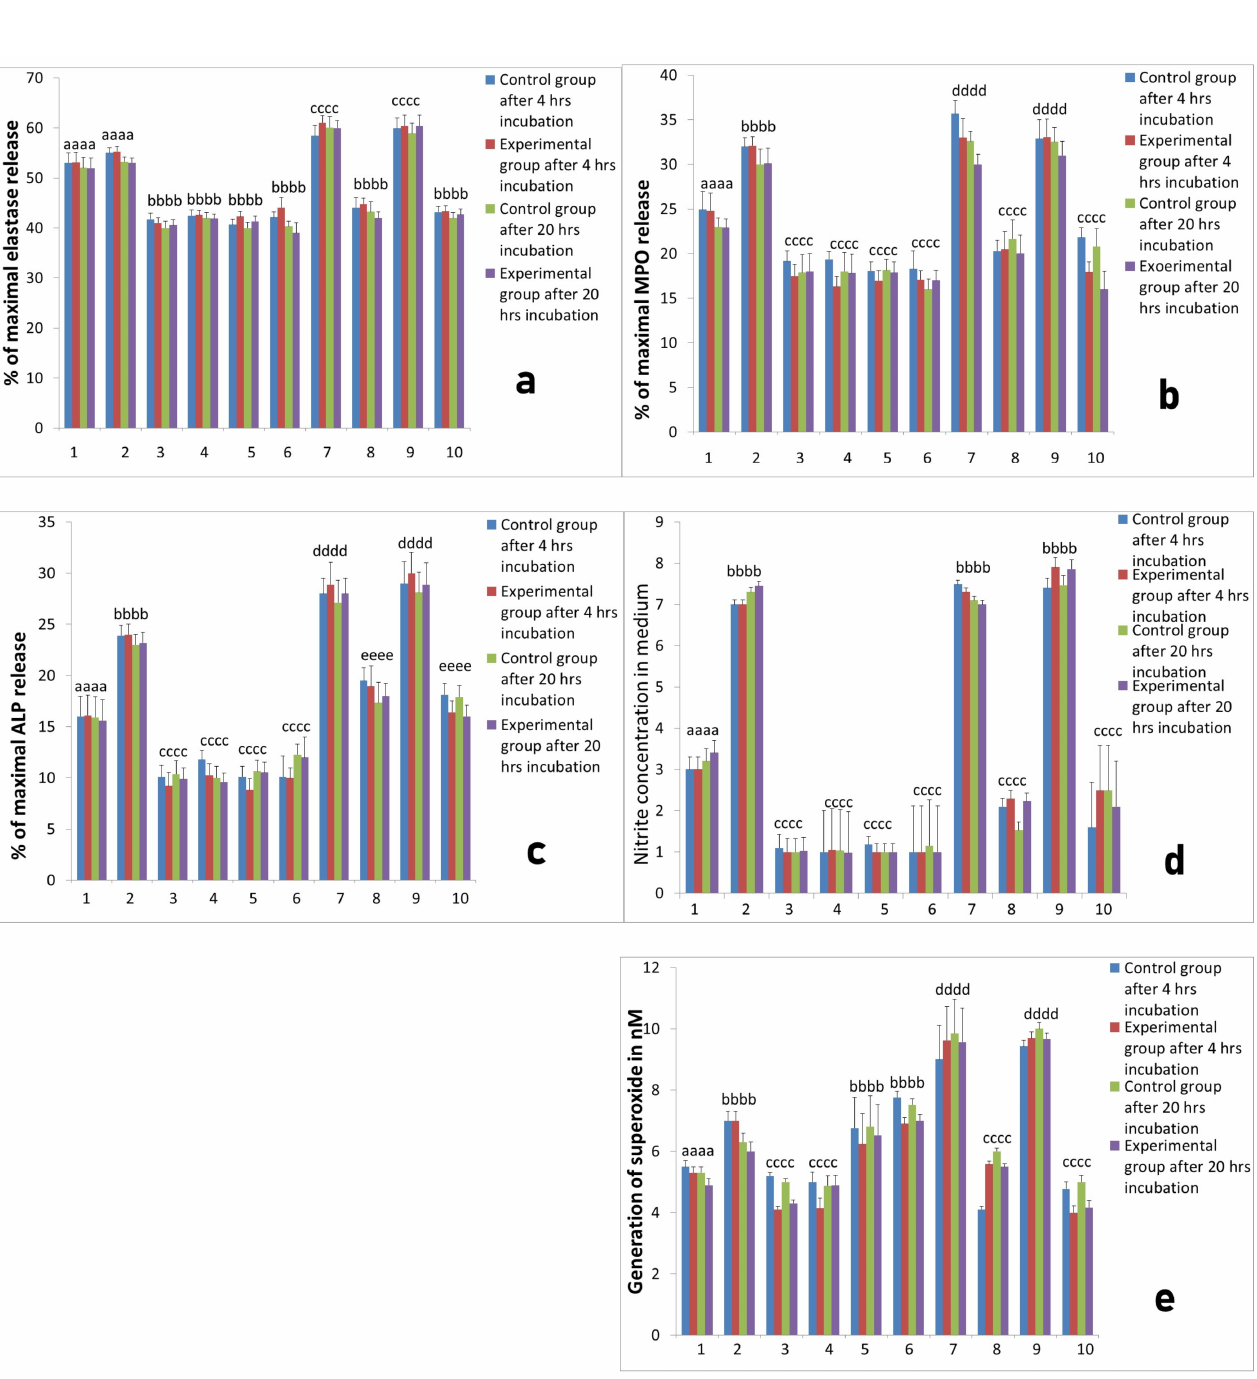
Figure 9. The response of neutrophils isolated 10 months after implantation to different PRP-derived products with or without additional stimulation with LPS. Cultures were incubated for 4 h or for 20 h at 37 ◦ C and 5% CO 2 . Data present mean values ± SE of at least three replicates for each bar. The neutrophil response was assessed with respect to: ( a ) elastase release from neutrophils, ( b ) MPO release, ( c ) ALP release, ( d ) NO generation, ( e ) superoxide generation. Values marked with different letters differed significantly ( p < 0.05). Legends: 1—neutrophil without stimulation, 2—after stimulation LPS, 3—after stimulation PPP from L-PRP, 4—after stimulation PPP from PURE PRP, 5—after stimulation PPP from L-PRP with LPS, 6—after stimulation PPP from PURE PRP with LPS, 7—after stimulation L-PRP, 8—after stimulation PURE PRP, 9—after stimulation L—PRP with LPS, 10—after stimulation PURE PRP with